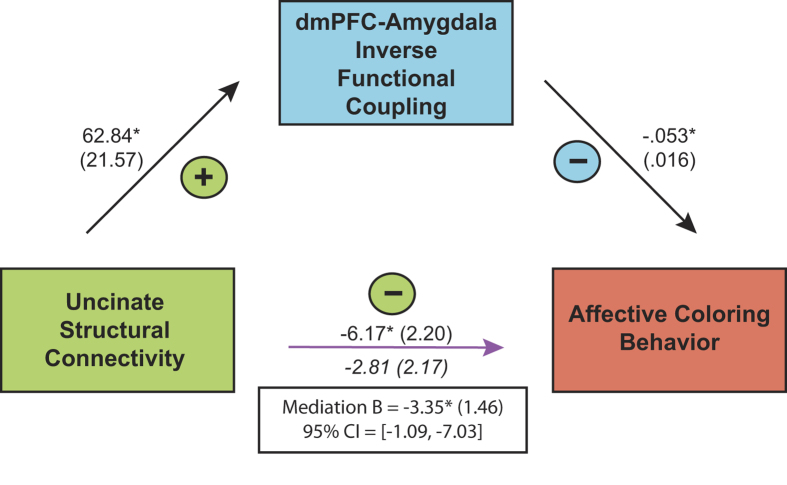
dmPFC-amygdala inverse functional coupling significantly mediated the association between uncinate structural connectivity (FA) and affective coloring behavior following aware processing of negative stimuli [fearful faces – flowers].Paths are marked with unstandardized coefficients (standard error).